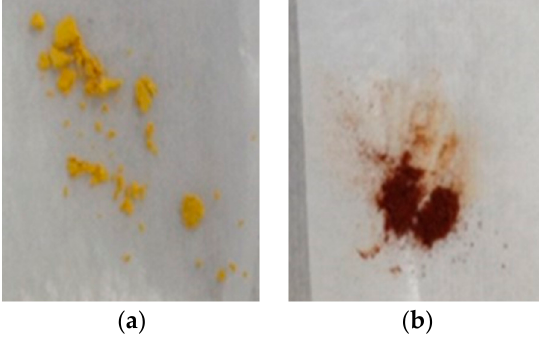
Figure 1. Yellow Folic Acid ( a ) and red Selenofolate ( b ).